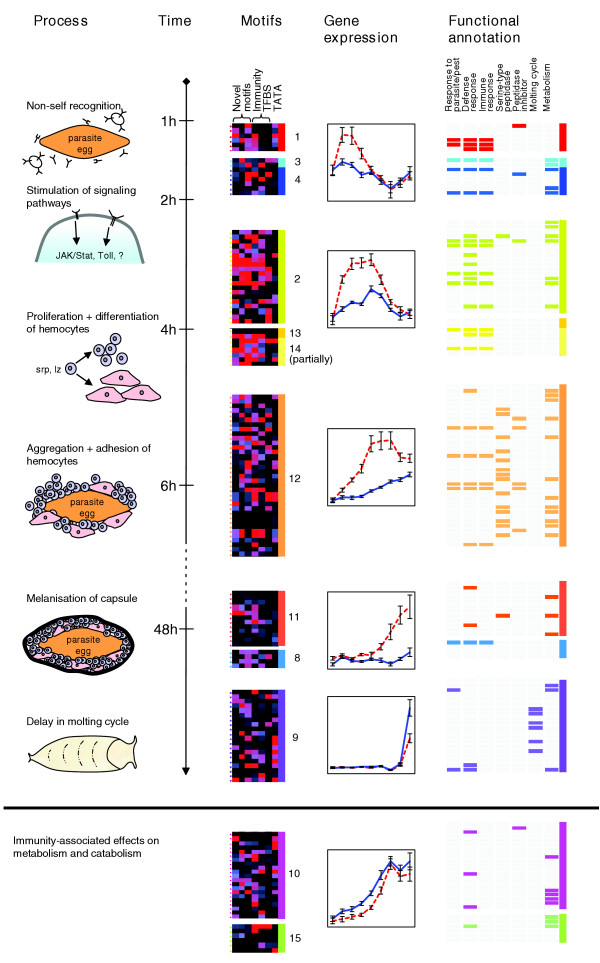
Overview and summary of our findings. The two left-hand columns show the time elapsed since parasitoid attack and a diagrammatic summary of major cellular and metabolic consequences of parasitism. The three right hand columns show the results of this study and the gene clusters that we hypothesize are associated with the different processes sketched on the far left. These three columns show the following: over-represented transcription factor binding motifs arranged by cluster (with code number) ordered by their time of maximum expression; average expression profiles of genes in these clusters (parasitized larvae in red, unparasitized larvae in blue) with marked temporal restricted expression; and functional annotations associated with genes in these clusters, in the same order as in the first of the three columns. A group of genes with relatively constant levels of reduced expression in parasitized larvae is shown separately at the bottom.